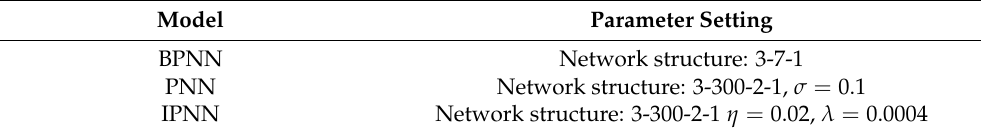
Table 3. Deception detection model.